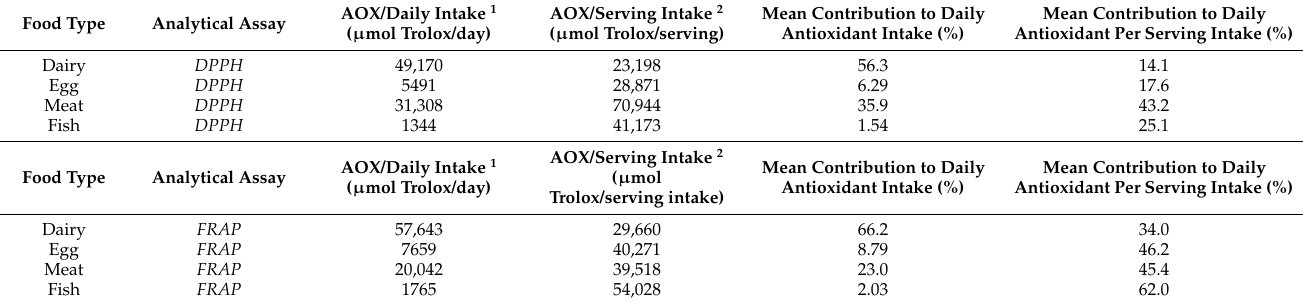
Table 1. Contribution of food of animal origin consumption to the daily antioxidant capacity (AOX) intake in the Spanish diet. Food